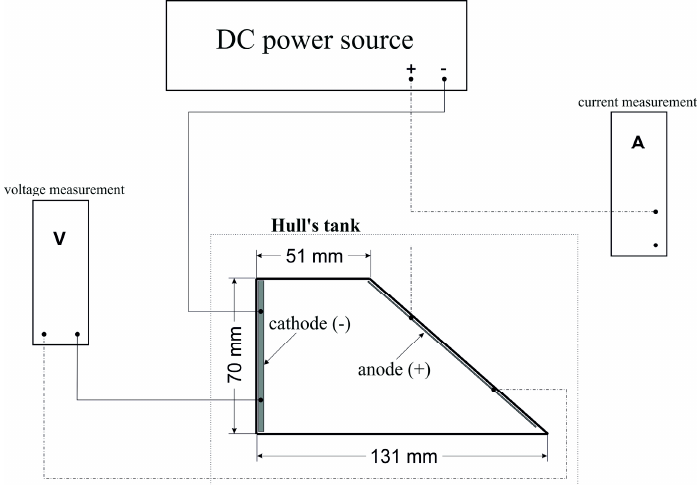
Figure 1. Diagram of the Hull’s tank connection.